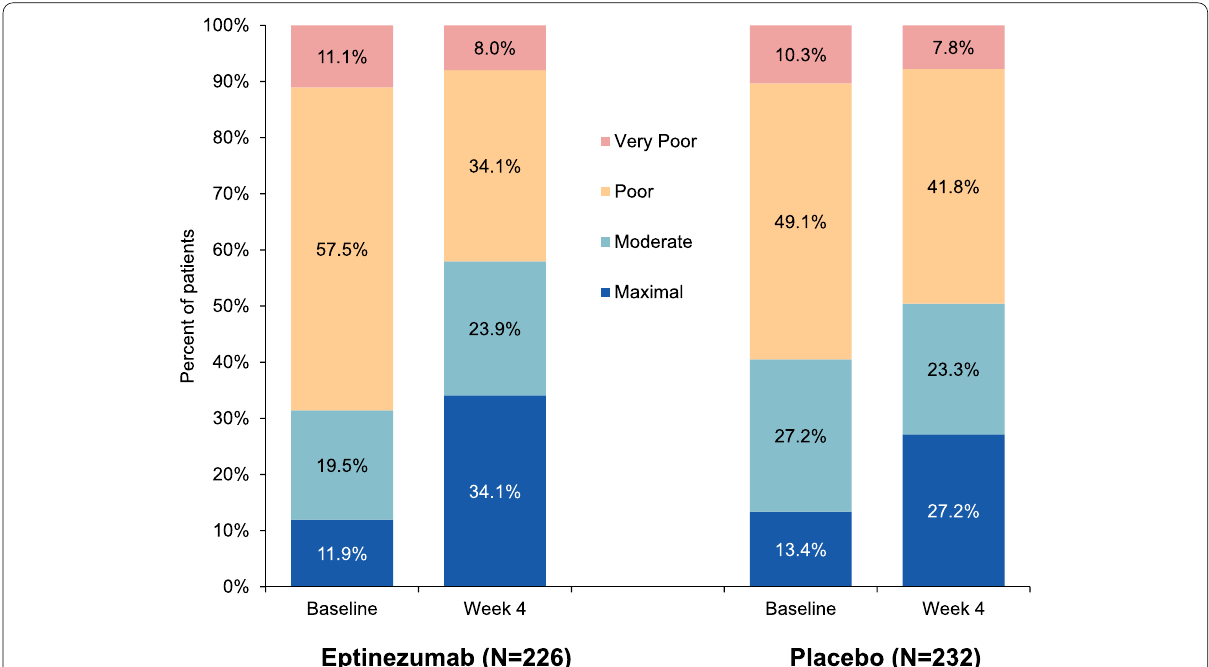
Fig. 1 Distribution of acute medication optimization (mTOQ-4) at baseline and week 4. The mTOQ-4 was derived from the mTOQ-6 by selecting the items that best assessed efficacy: “2-h pain free,” “24-h relief,” “able to plan,” and “in control.” Each item is rated never (1), rarely (2), less than half the time (3), or half the time or more (4). Patients were grouped by baseline mTOQ-4 total scores into the following optimization categories: very poor (0), poor (1–5), moderate (6–7), and maximal (8). mTOQ-4/mTOQ-6, 4-item/6-item Migraine Treatment Optimization